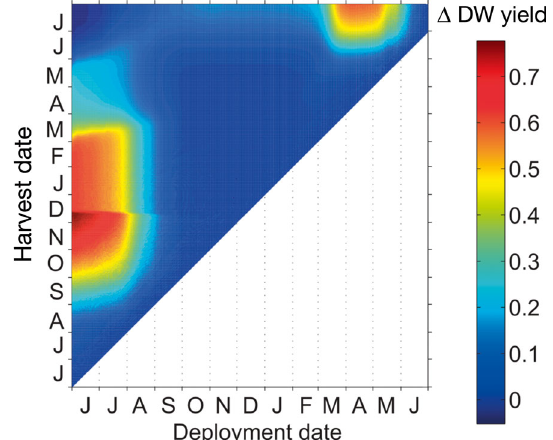
Fig. 12. Saccharina latissima . Relative effect of salmon farm Fig. 13. Saccharina latissima . Nitrogen uptake (30 d running NH 4 3 -N on a single S. latissima sporophyte (deployed at 5 m means) expressed as daily fractions of uptake for the entire cultivation period versus deployment dates depth), interpreted as a function of deployment and harvest date. Each vertical line represents the development of 1 de- ployment. Colours indicate the relative difference in dry weight (DW) between Simulation C N and C (see Table 2 for details on simulations)